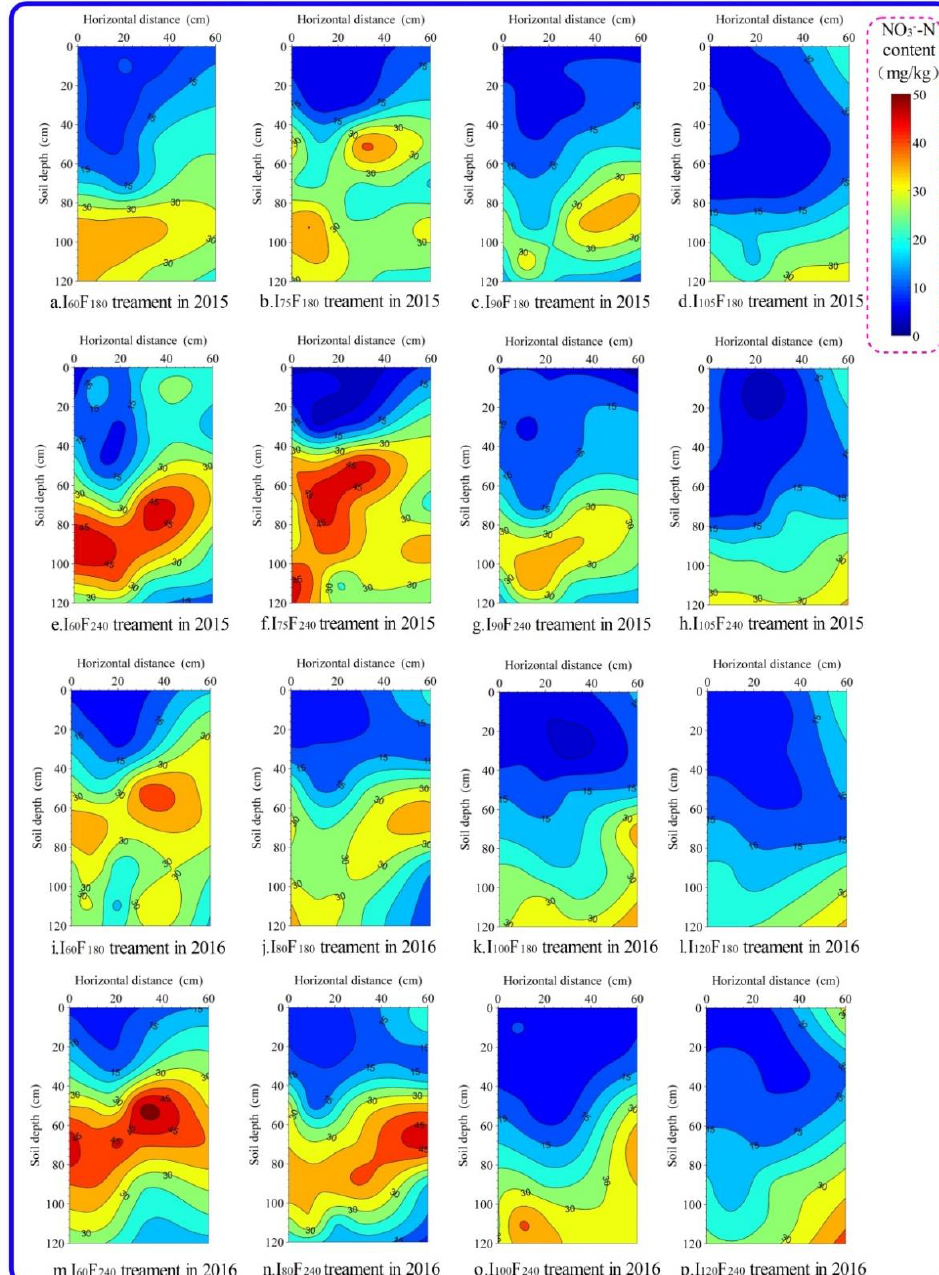
Figure 8. Effects of different irrigation and fertigation treatments on soil NO 3 − -N content distribution in root layers of maize in 2015 and 2016.